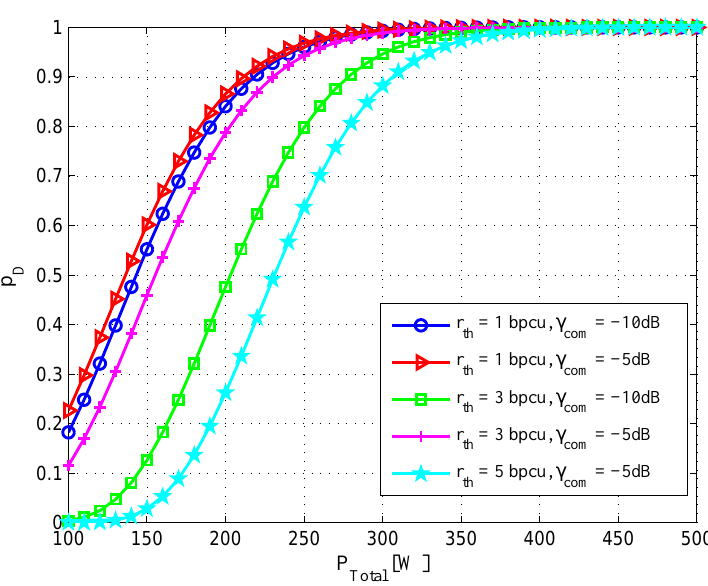
Figure 3. Probability of detection p D versus total transmit power P Total with different r th and γ com ( δ FA = 10 − 6 , γ rad = − 10 dB).